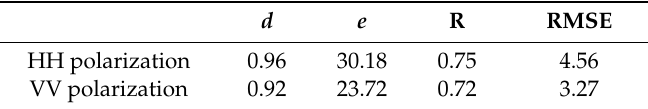
Table 4. The unknown coefficient of empirical model.